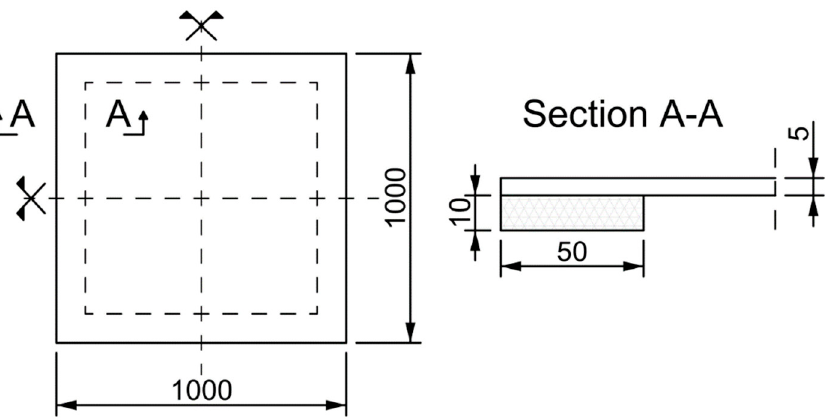
Figure 6. Studied monolithic glass panel: front view and cross ‐ sectional detail in the region of supports (dimensions in mm).